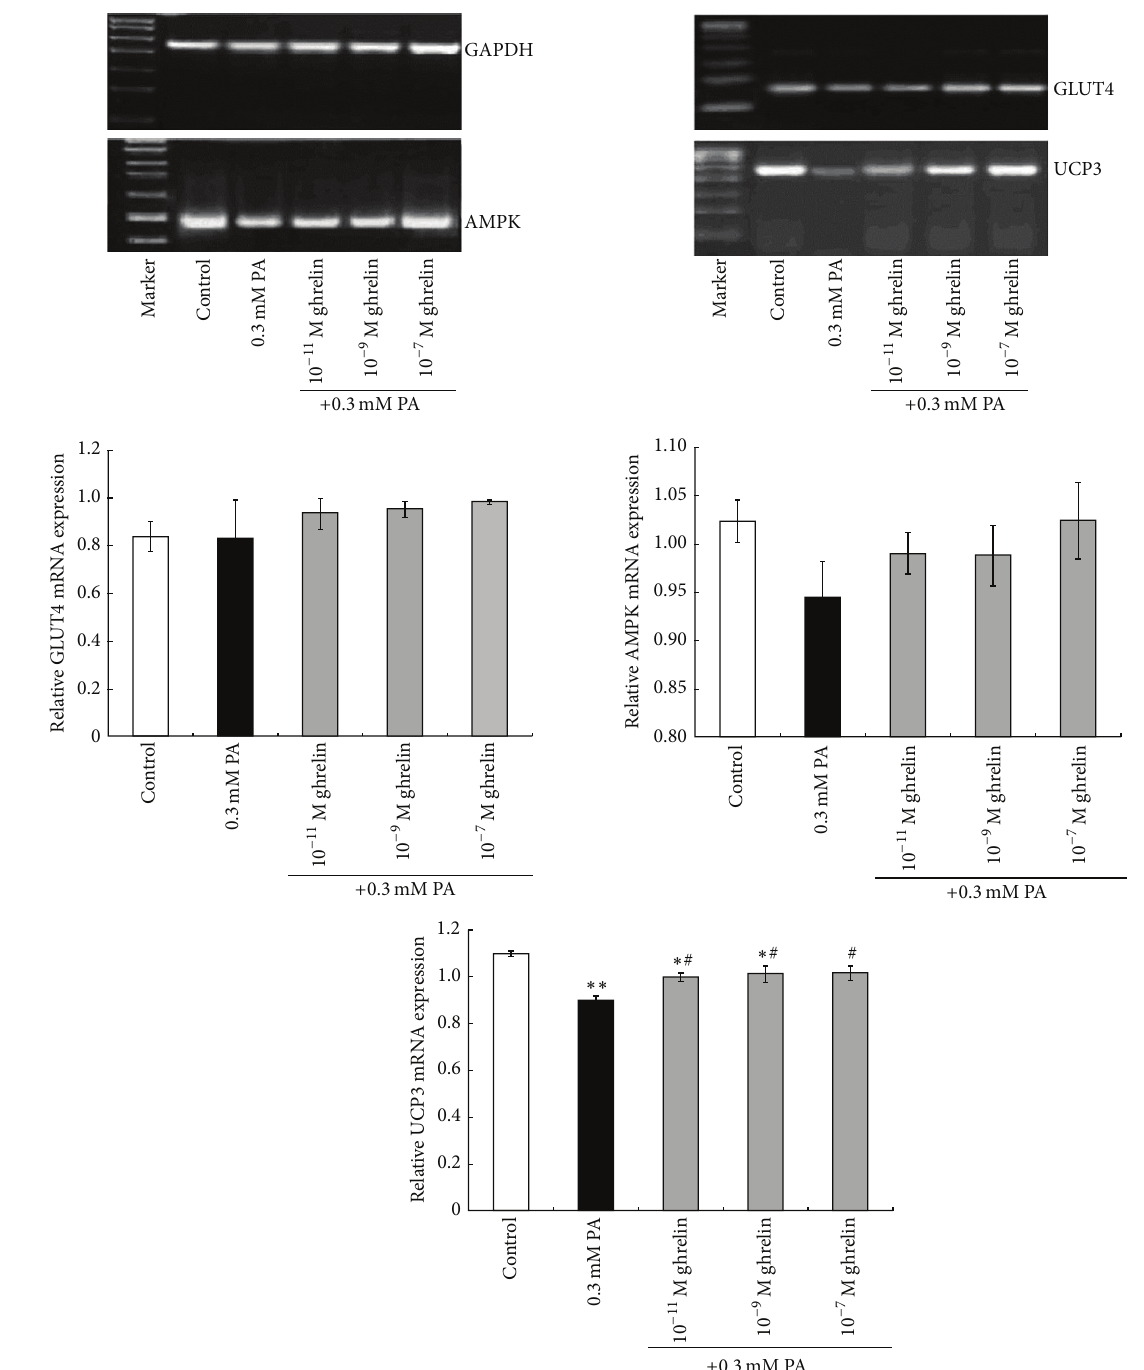
Figure 5: Effects of acylated ghrelin on the mRNA expression of genes involved in lipid and glucose metabolism. mRNA expression of the glucose transporter 4 (GLUT4), AMP-activated protein kinase (AMPK), and uncoupling protein 3 (UCP3) in primary cultured rat myoblasts under high fat conditions was determined by real-time polymerase chain reaction. Glyceraldehyde 3-phosphate dehydrogenase (GAPDH) was used as internal reference. Data are shown as mean ± SD. ∗ 𝑃 < 0.05 , ∗∗ 𝑃 < 0.01 versus controls; # 𝑃 < 0.05 versus the 0.3 mM PA